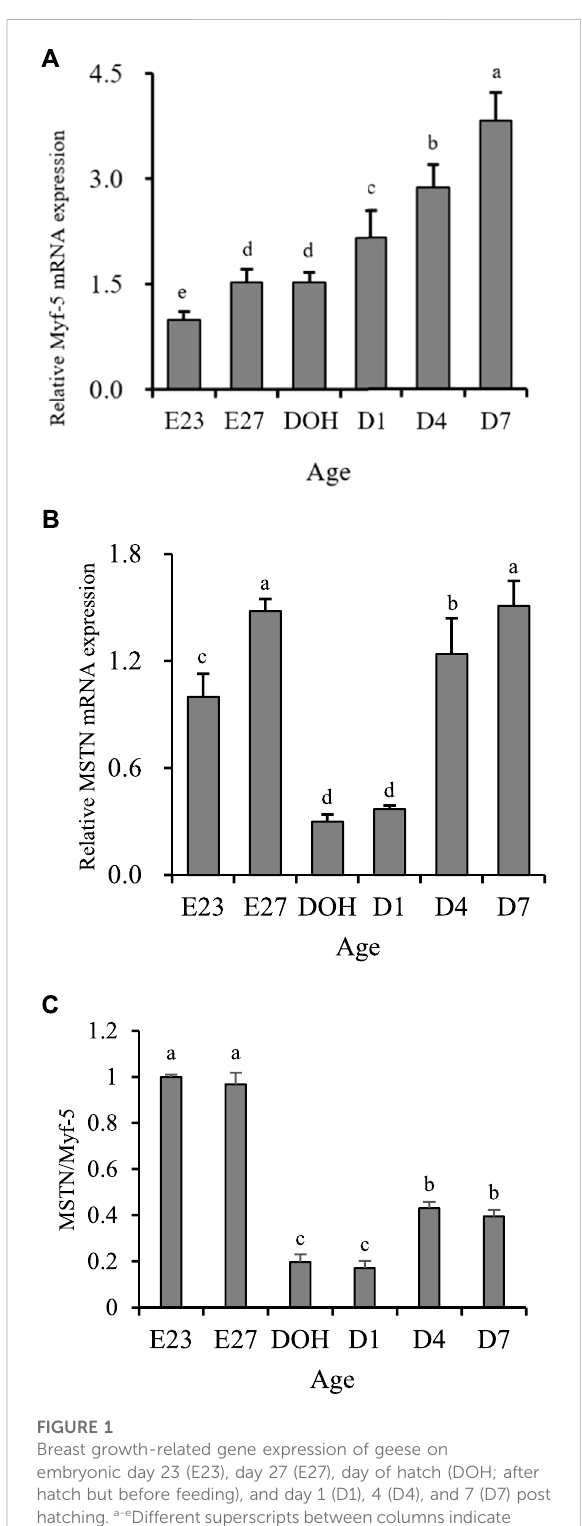
FIGURE 1 Breast growth-related gene expression of geese on embryonic day 23 (E23), day 27 (E27), day of hatch (DOH; after hatch but before feeding), and day 1 (D1), 4 (D4), and 7 (D7) post hatching. a-e Different superscripts between columns indicate signi fi cant difference ( P < 0.05). The data are presented as the mean ± standard deviations. The value presents the means of six samples (values from the three birds were pooled to form one sample) per sampling timepoint ( n = 6). Sampling timepoint of E23 was used as the untreated control timepoint (value = 1). a- e Different superscripts within a column indicate a signi fi cant difference ( p <